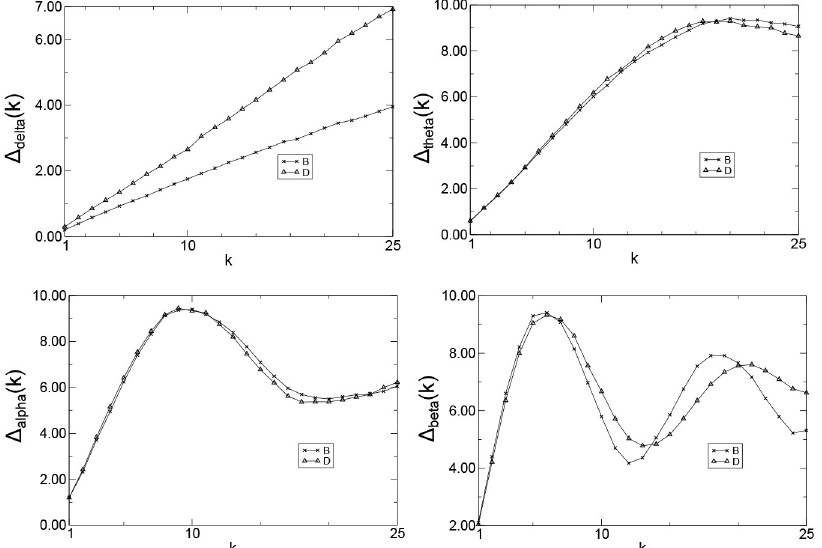
Fig 6. Δ ( k ) versus k (channel P 3 ), T = 1, 024, Q = 20, and k = 1, 2, ... , 25 for delta ( Δ and beta ( Δ beta ) waves and patients for the groups B and D.